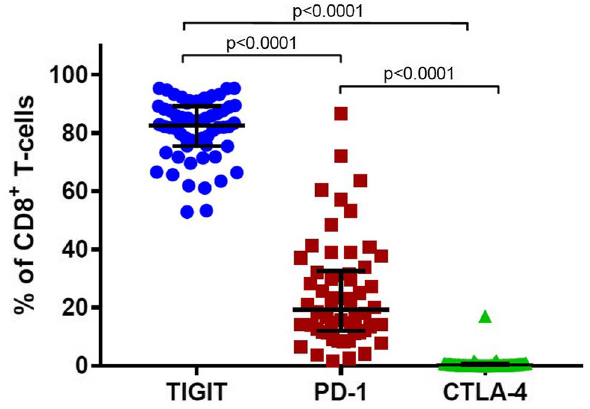
Fig. 3 The expression of inhibitory immune checkpoint receptors on CD8 + T-cells from all patients ( n =